Question: Generate an informative caption for the figure above.
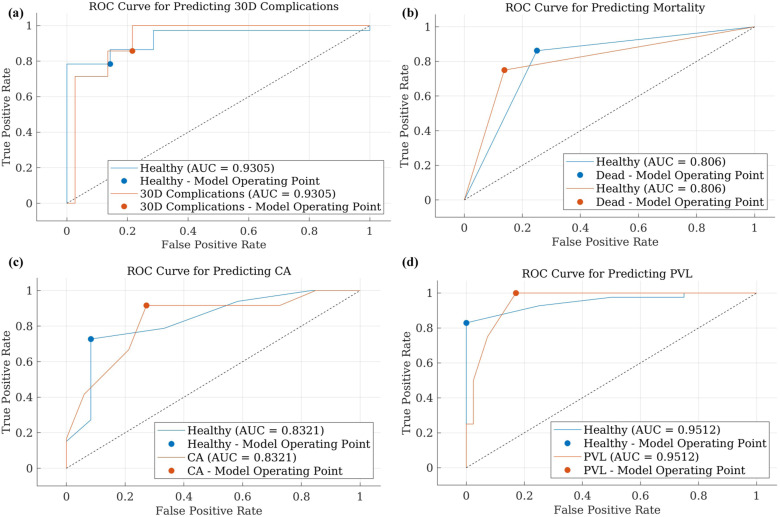
Answer: ROC curves for (a) 30D Complication, (b) Mortality, (c) CA, and (d) PVL prediction.